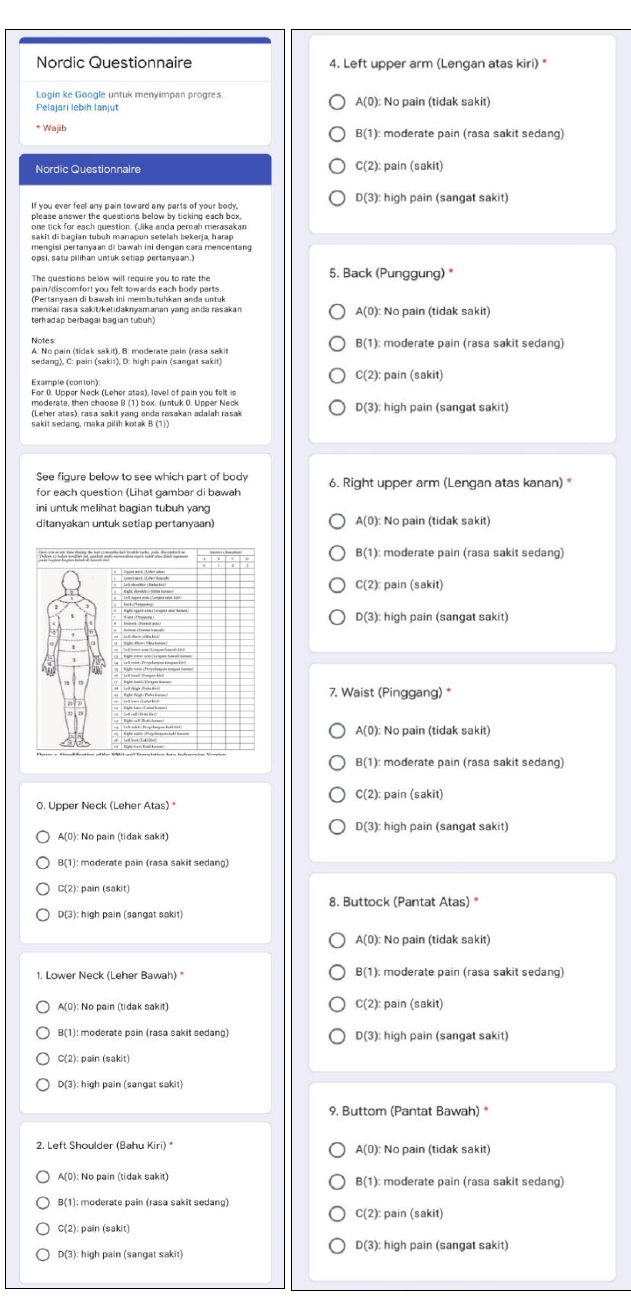
Figure A1. Example of the Nordic Body Map Questionnaire.